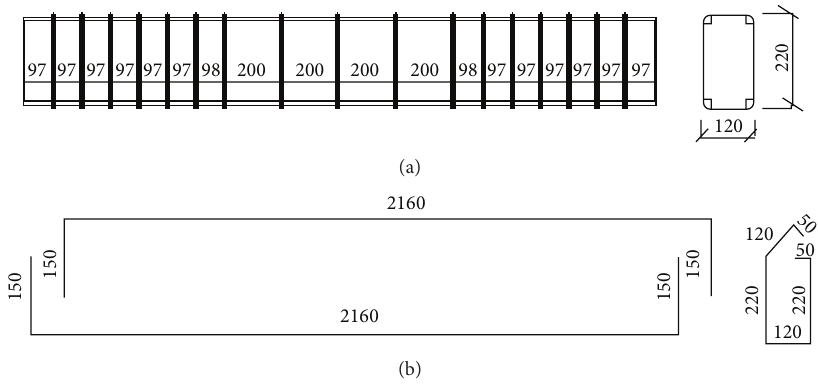
Figure 1: Reinforcement details of the experimental beams [12].